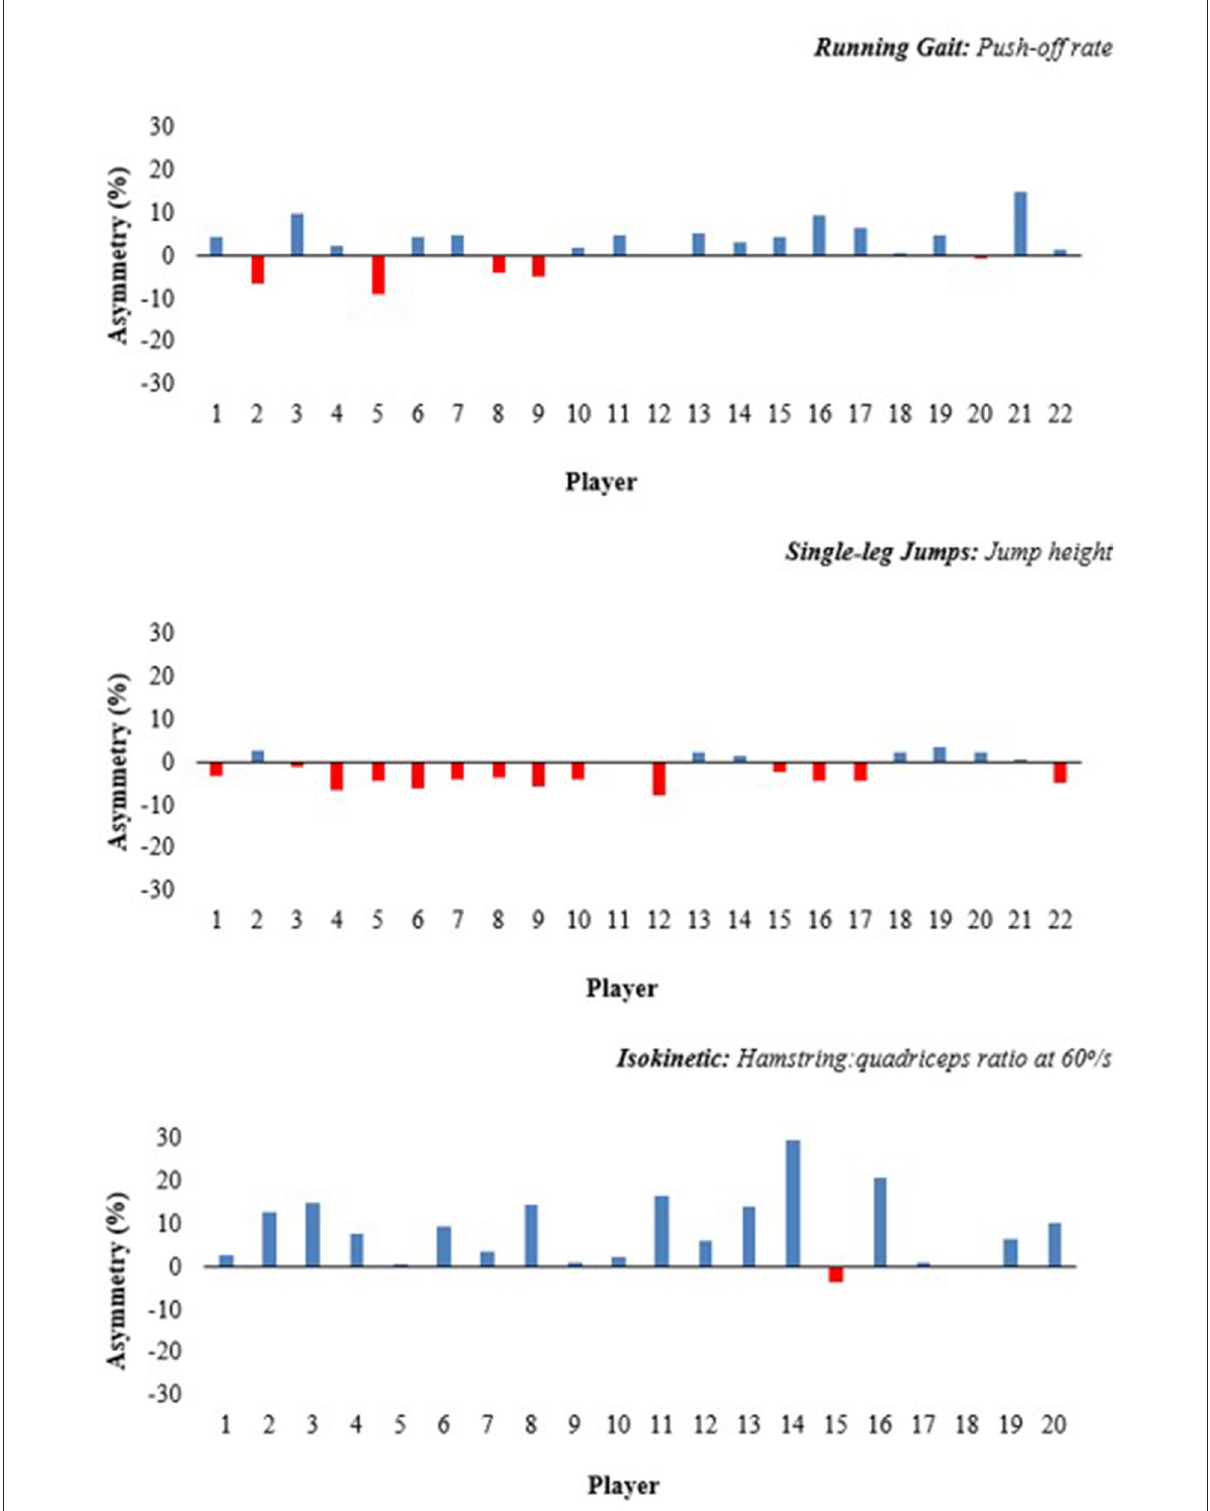
FIGURE1 Individual asymmetry data for the top: running gait push-off rate, middle: single-leg jump height, bottom: conventional hamstring: quadriceps (H:Q) ratio measured at 60 ◦ /s. Above the line indicates a score that is greater on the preferred kicking limb and a negative score represents a value that is greater on the non-preferred kicking